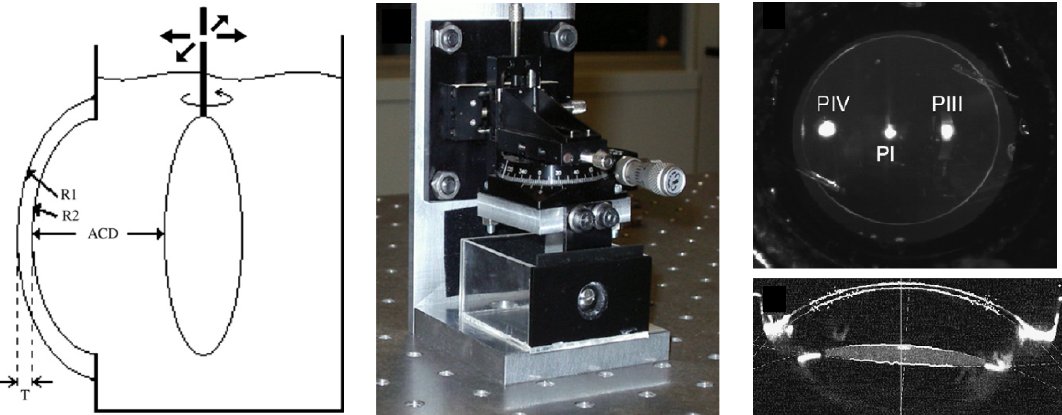
Figure 7. ( Left ) Scheme depicting the device used by De Castro et al. R1, R2 and T are the ante- rior/posterior radii and thickness of the artificial cornea. ACD is the anterior chamber depth. The arrows show that the IOL can be translated and rotated; ( Center ) photograph of the fully mounted device used by De Castro; ( Right ) ray images acquired from the Purkinje ( top ) and Scheimpflug ( bottom ) systems used by De Castro at al. Journal of Cataract and Refractive Surgery 2007, 33, 418–429 ([22]). Originally published by and reprinted with permission from Wolters Kluwer Health Inc.